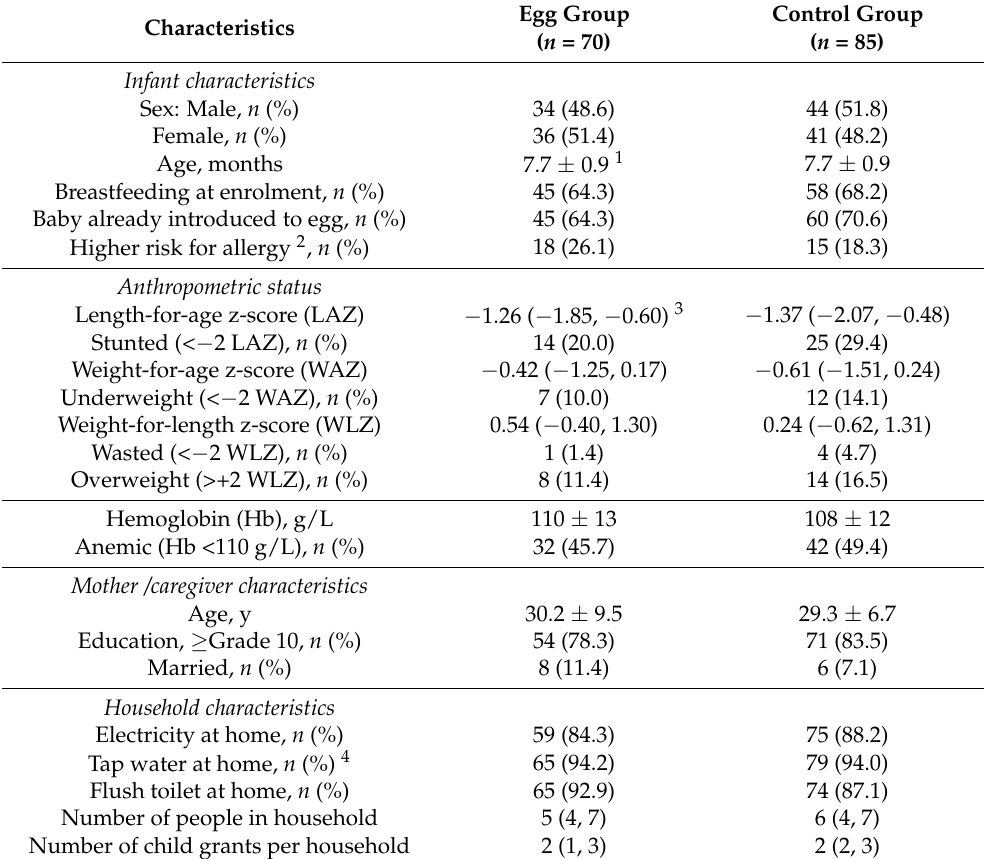
Table 1. Baseline characteristics of the 155 participants at